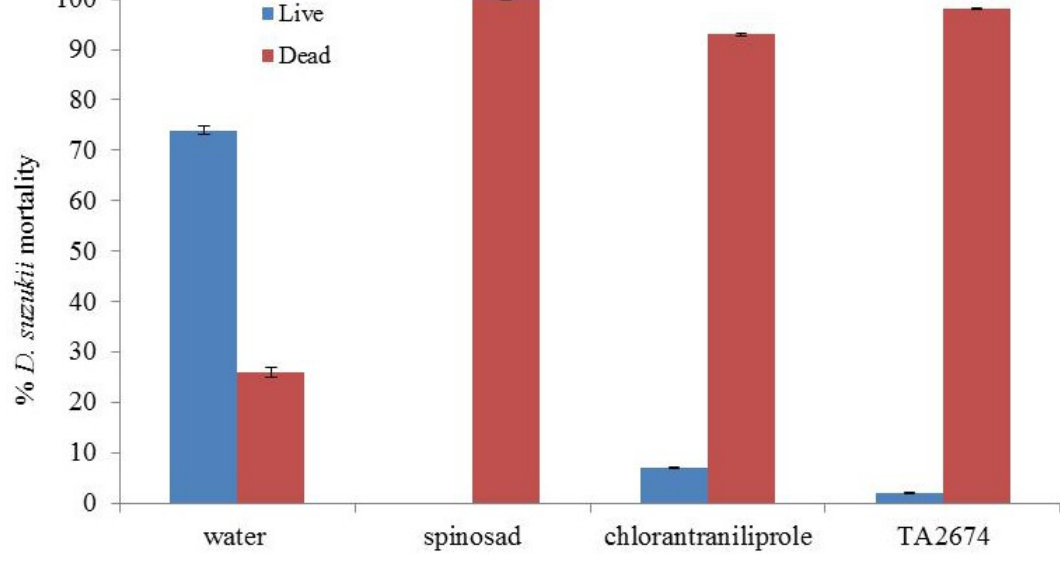
Figure 8. Mortality observed of adult Drosophila suzukii flies following exposure to pre-treated blueberries. Mortality assessed after 48 hours (100 flies per